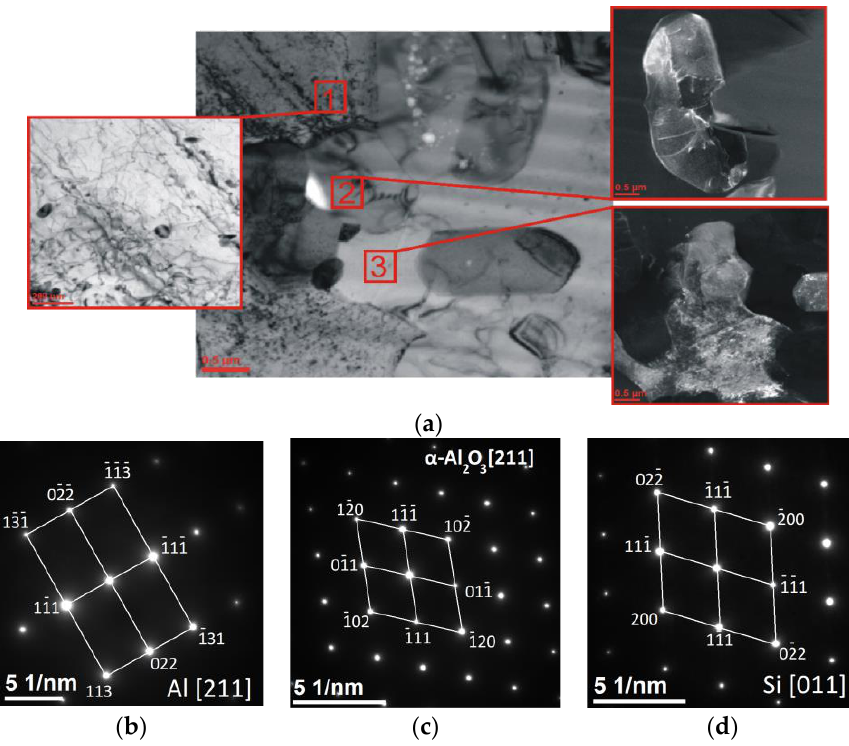
Figure 9. STEM-BF image ( a ) of aluminium (1), alumina (2), and silicon (3) in a composite material, produced by sintering a ceramic phase at 1600 °C, infiltrated at a pressure of 3 MPa. SAED diffraction images of selected grains of ( b ) aluminium, ( c ) alumina, and ( d ) silicon.